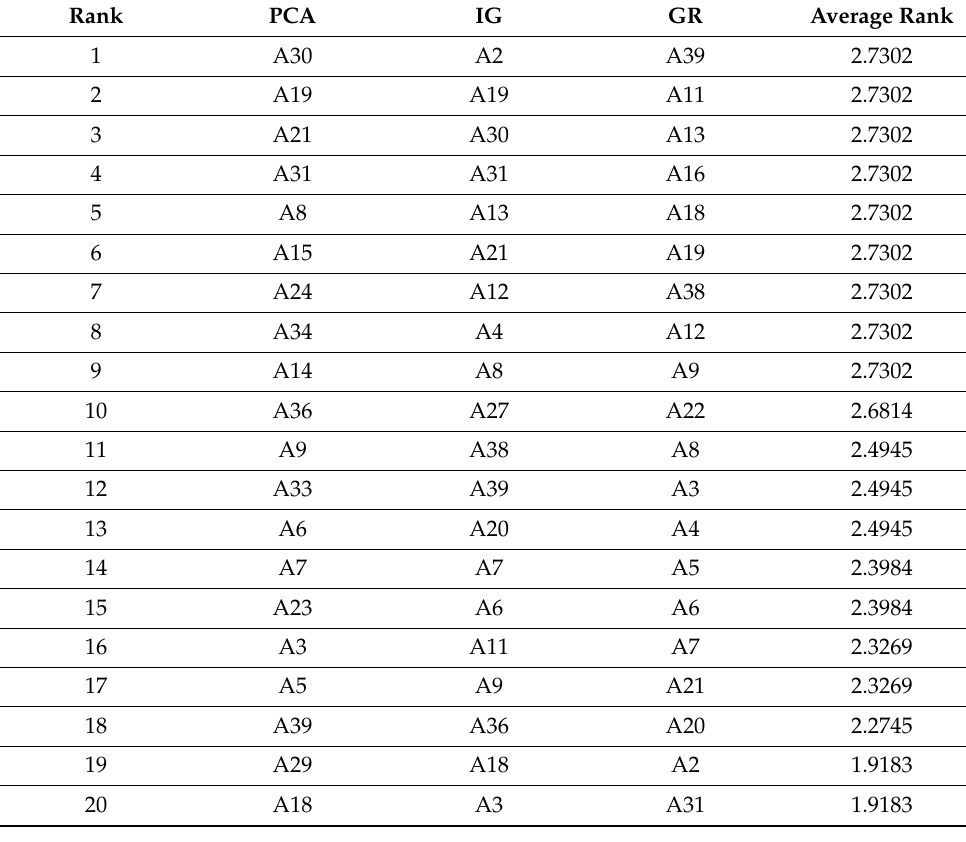
Table 5. Feature selection sorting.